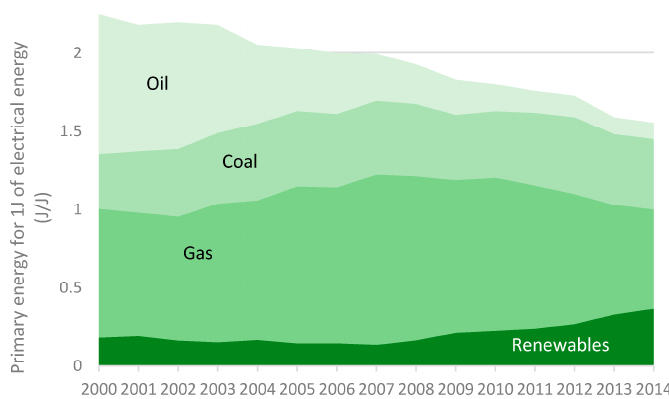
Figure A1. Primary energy equivalent of 1 J of electrical energy in Italy. Source [35].